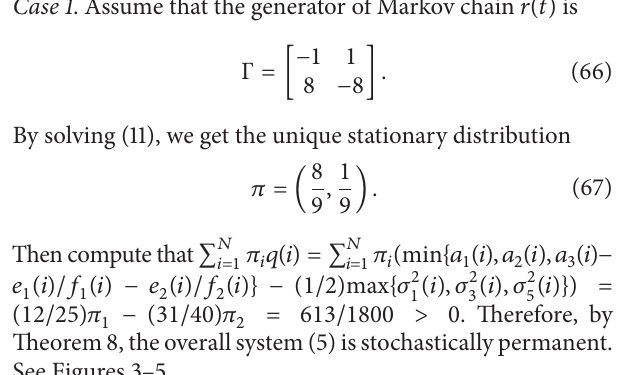
Figure 3: (Stochastic permanence) the trajectories of the solution (𝑥(𝑡),𝑦(𝑡),𝑧(𝑡)) for the overall system (5) in Case 1 of Example 1. Case 1 . Assume that the generator of Markov chain 𝑟(𝑡)